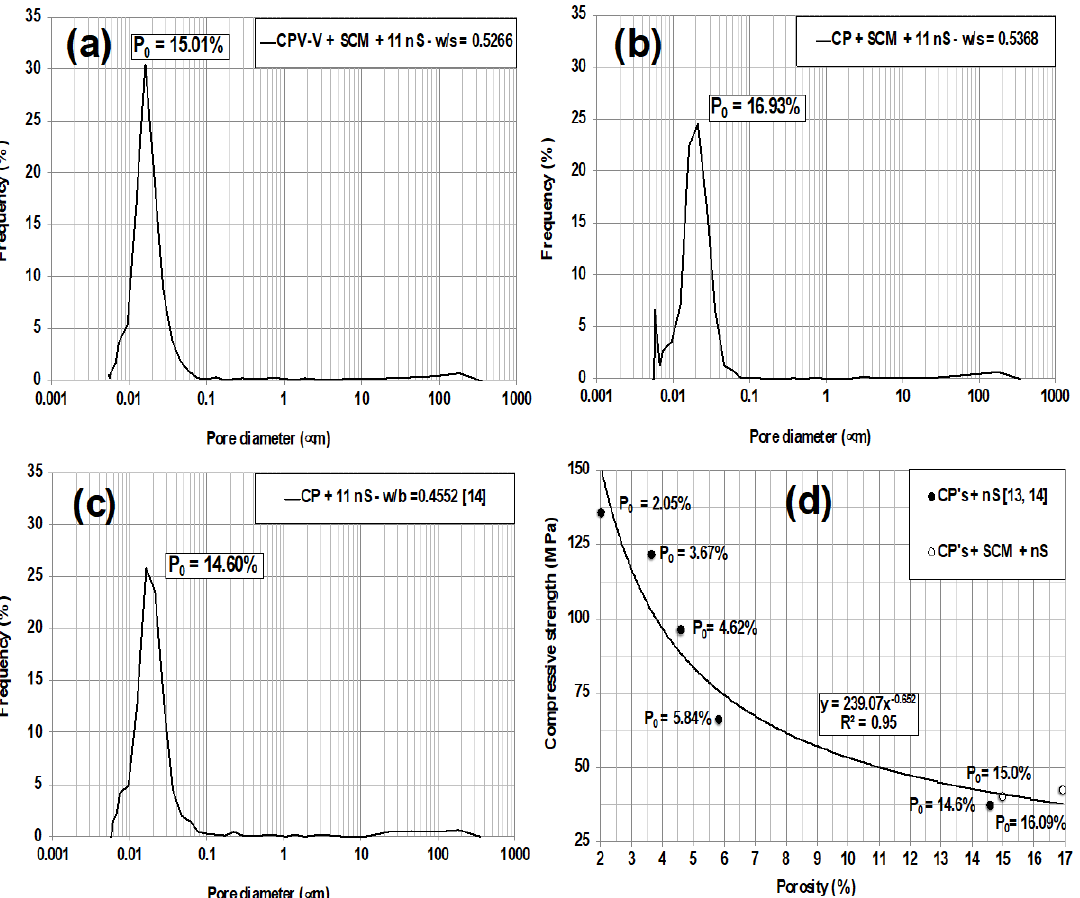
Figure 6. Mercury intrusion porosimetry (a) CPV-V + SCM + 11 nS (b) CP + SCM + 11 nS (c) CP + 11 nS and [14] (d) Compressive strength vs Porosity of Portland cement matrices containing nano-silica with and without SCM [13],